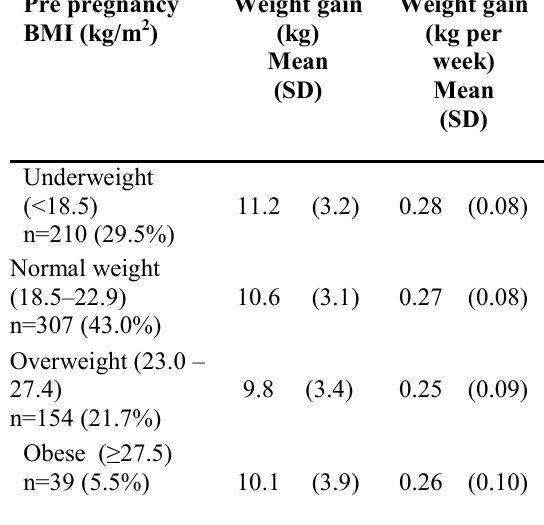
Table 3 – Weight gain pattern in normal pregnan- cies, by pre pregnancy BMI